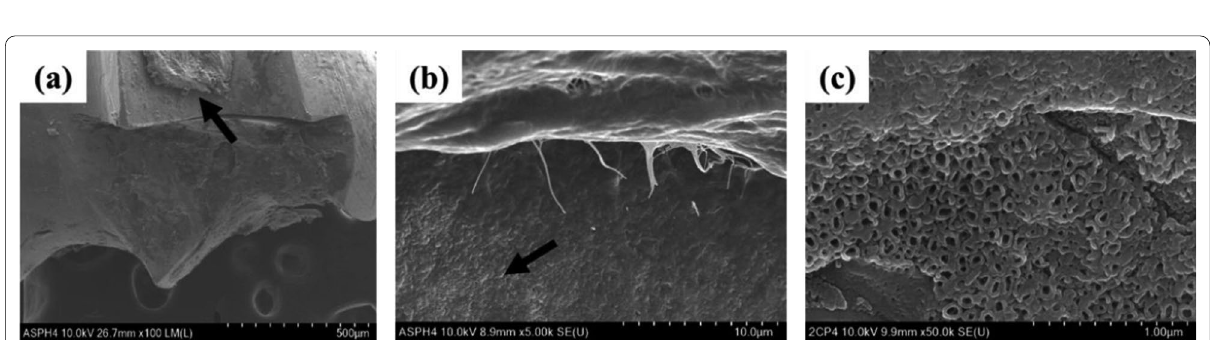
Fig. 10 Surface morphology of the APH group mini‑screw removed 4 weeks after implantation into rabbit tibias. a 100 5 k magnification, c 50 k magnification. The arrows in a and b indicate the locations where b and c images were taken, × ×